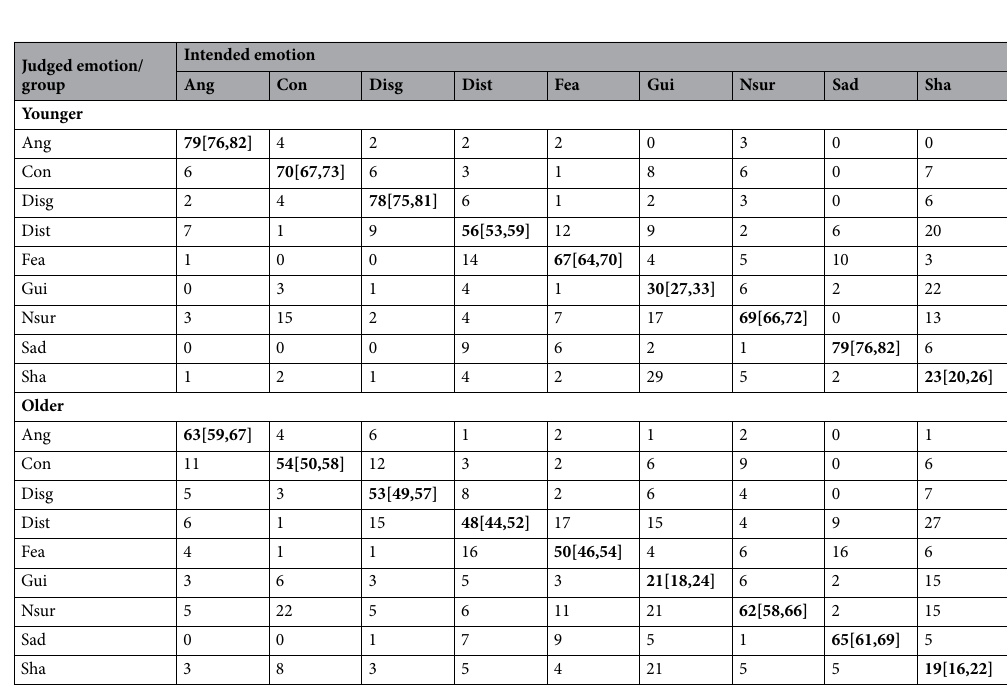
Table 3. Confusion matrix showing the proportion of judgments in Task 2 (negative nonlinguistic vocalizations) for each intended emotion and for both age groups. Diagonal cells represent the percentage of correct responses (marked in bold typeface). Numbers in brackets indicate 95% CIs. Ang anger, Con contempt, Disg disgust, Dist distress, Fea fear, Gui guilt, Nsur negative surprise, Sad sadness, Sha